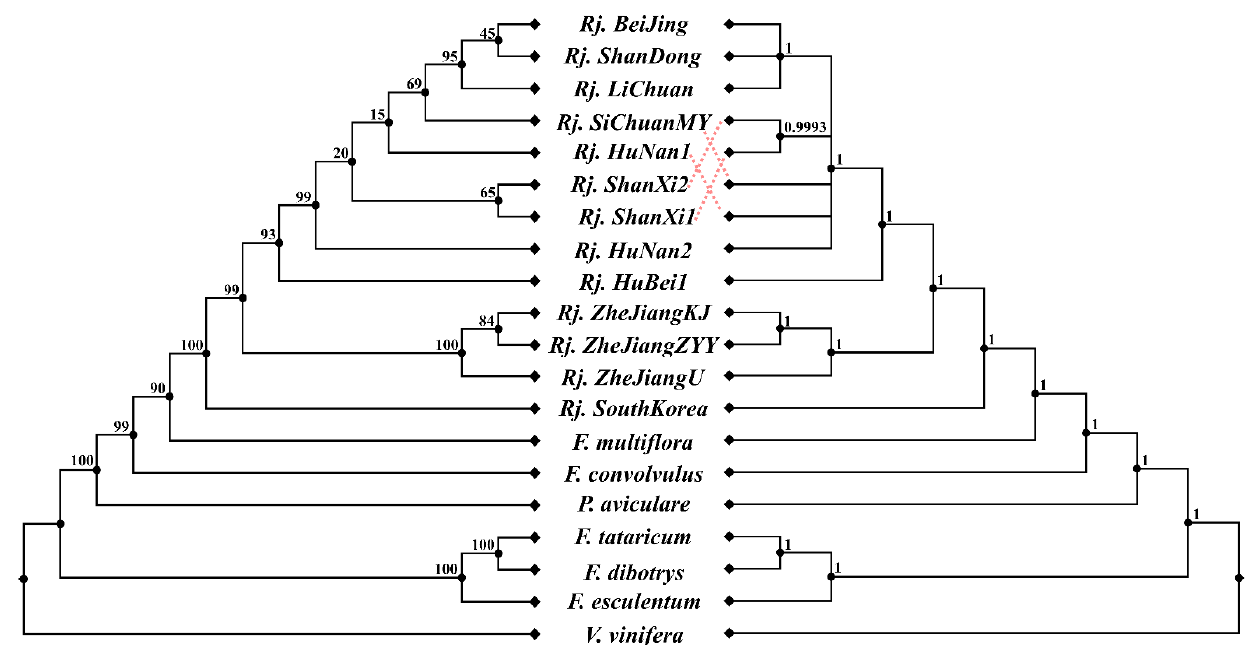
Genes 2022 , 13 , x FOR PEER REVIEW 10 of 15 Figure 5. Phylogenetic trees based on protein-coding genes. Maximum likelihood (ML) phylogenetic inference tree ( left ) and Bayesian inference (BI) tree ( right ); ML bootstrap support values/Bayesian posterior probabilities are shown at each node; F. convolvulus, Fallopia convolvulus; F. tataricum, Fagopyrum tataricum; F. dibotrys, Fagopyrum dibotrys; F. esculentum, Fagopyrum esculentum .